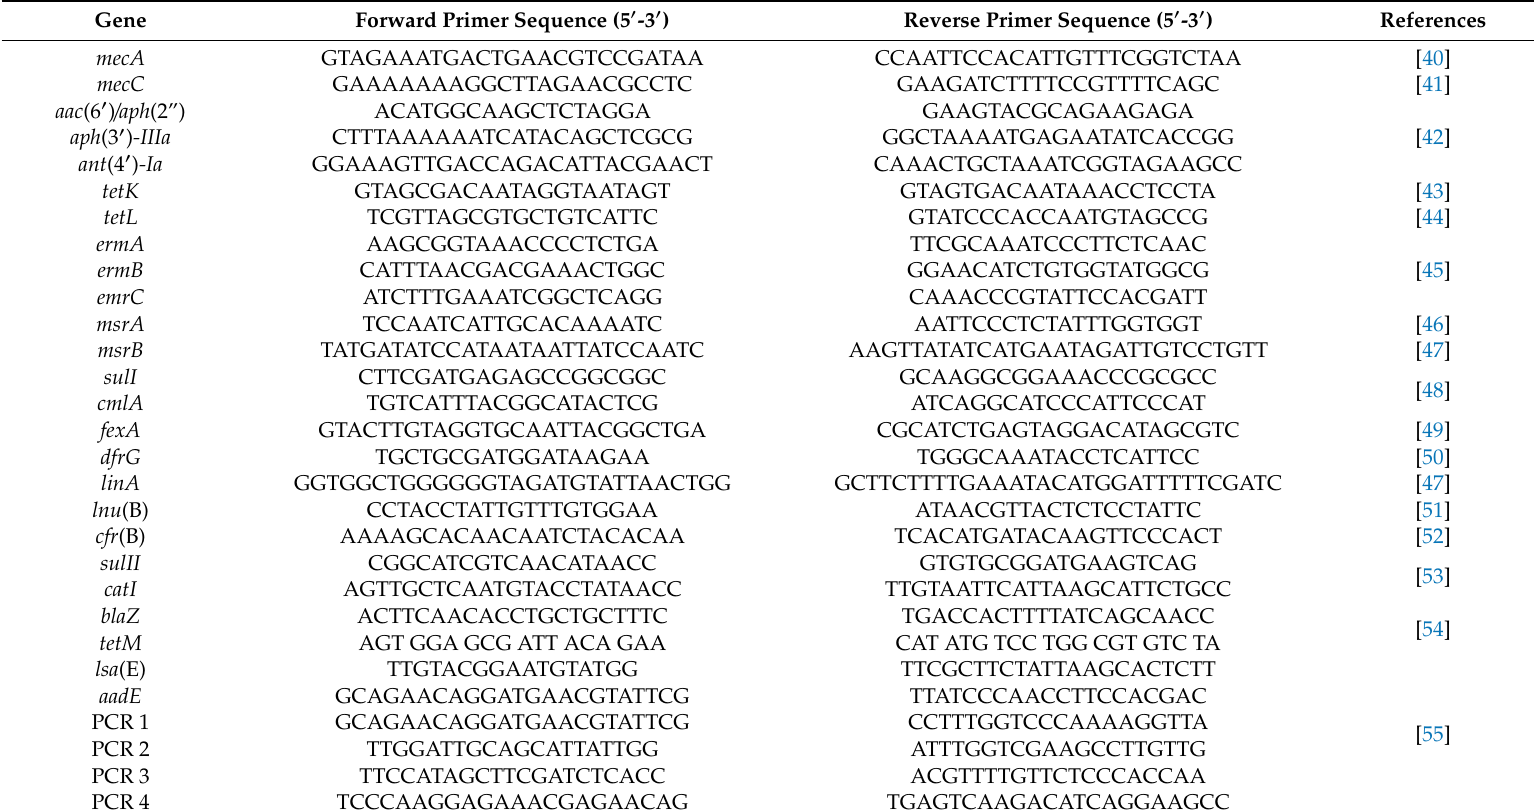
Table A1. Primers used